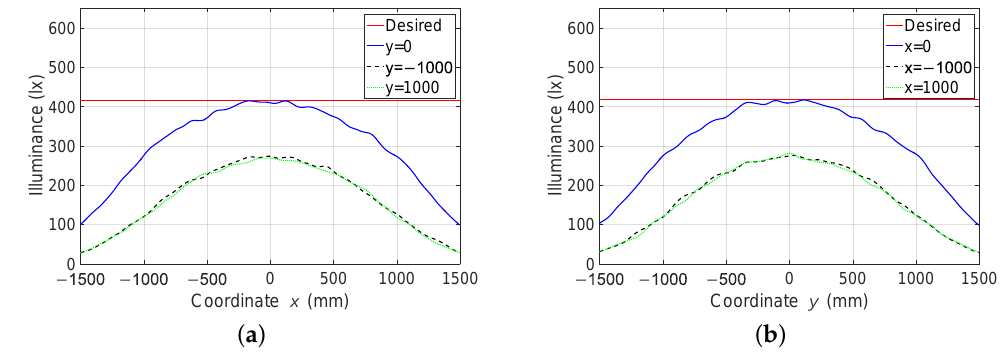
Figure 15. Illuminance distribution curves of the three profiles found using the Nelder-Mead opti- mization algorithm: ( a ) on the coordinate axis x and ( b ) on the coordinate axis y